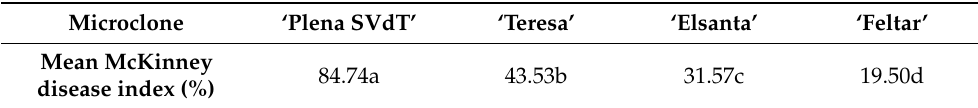
Table 5. Differences in the extent of Phytophthora disease development expressed by the mean McKinney disease index (%). Means marked with the same letter do not differ significantly at p ≤